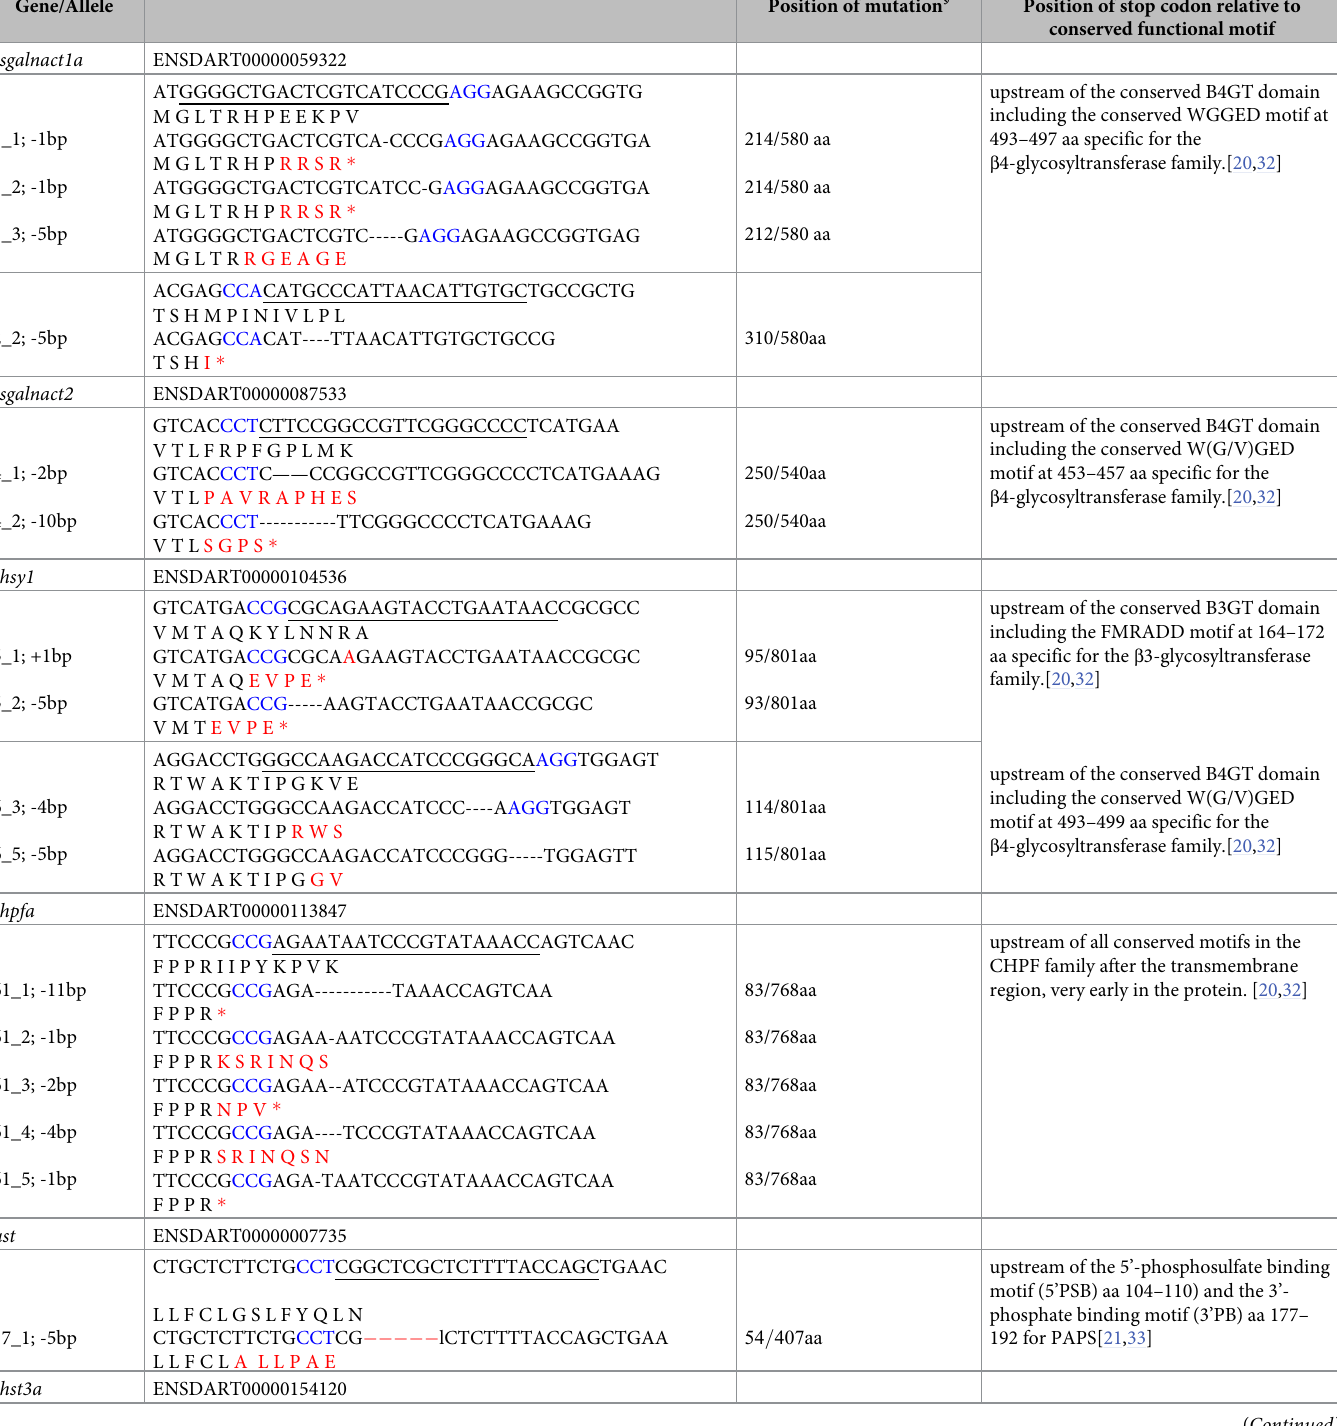
Table 1. Genomic and amino acid sequence for identified loss-of-function alleles. CRISPR target sequences are underlined and the PAM site is colored blue. Aberrant protein sequence is colored in red. Stop codon is indicated by a star ( � ). § (position of amino acid sequence interruption)/(total number of amino acids in